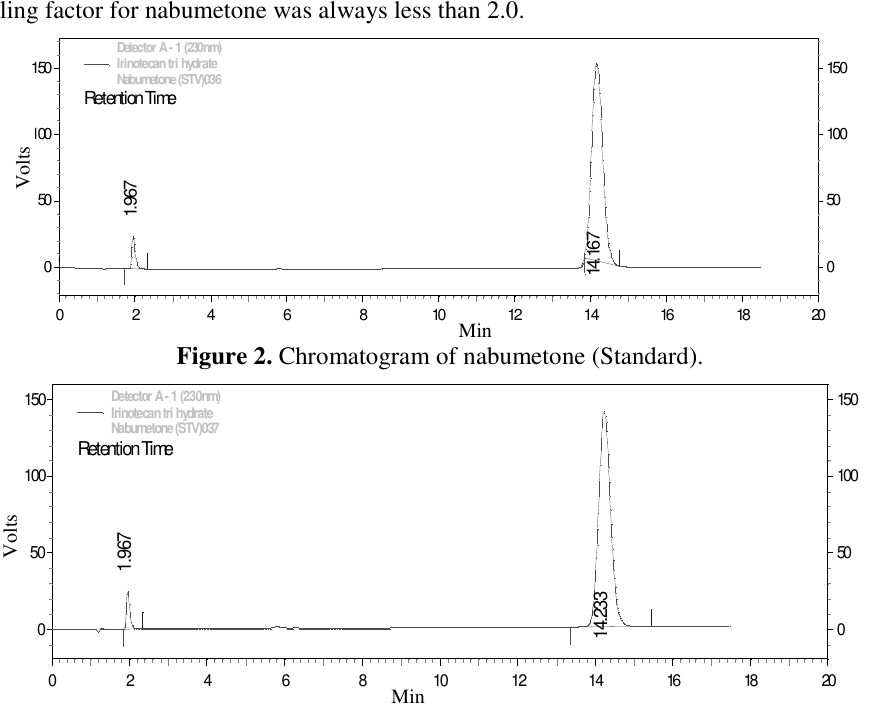
Figure 3. Chromatogram of nabumetone